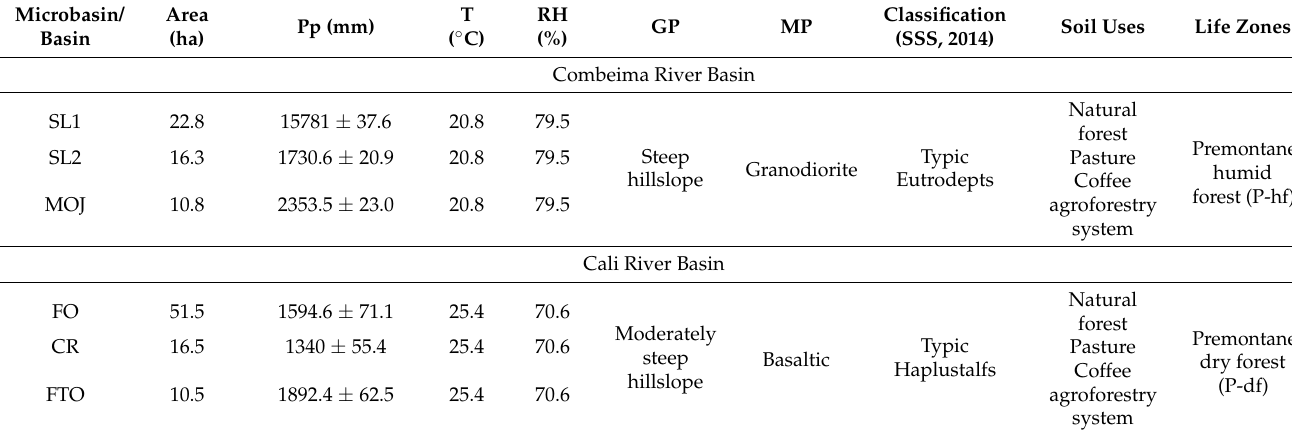
Table 2. Study sites and environmental